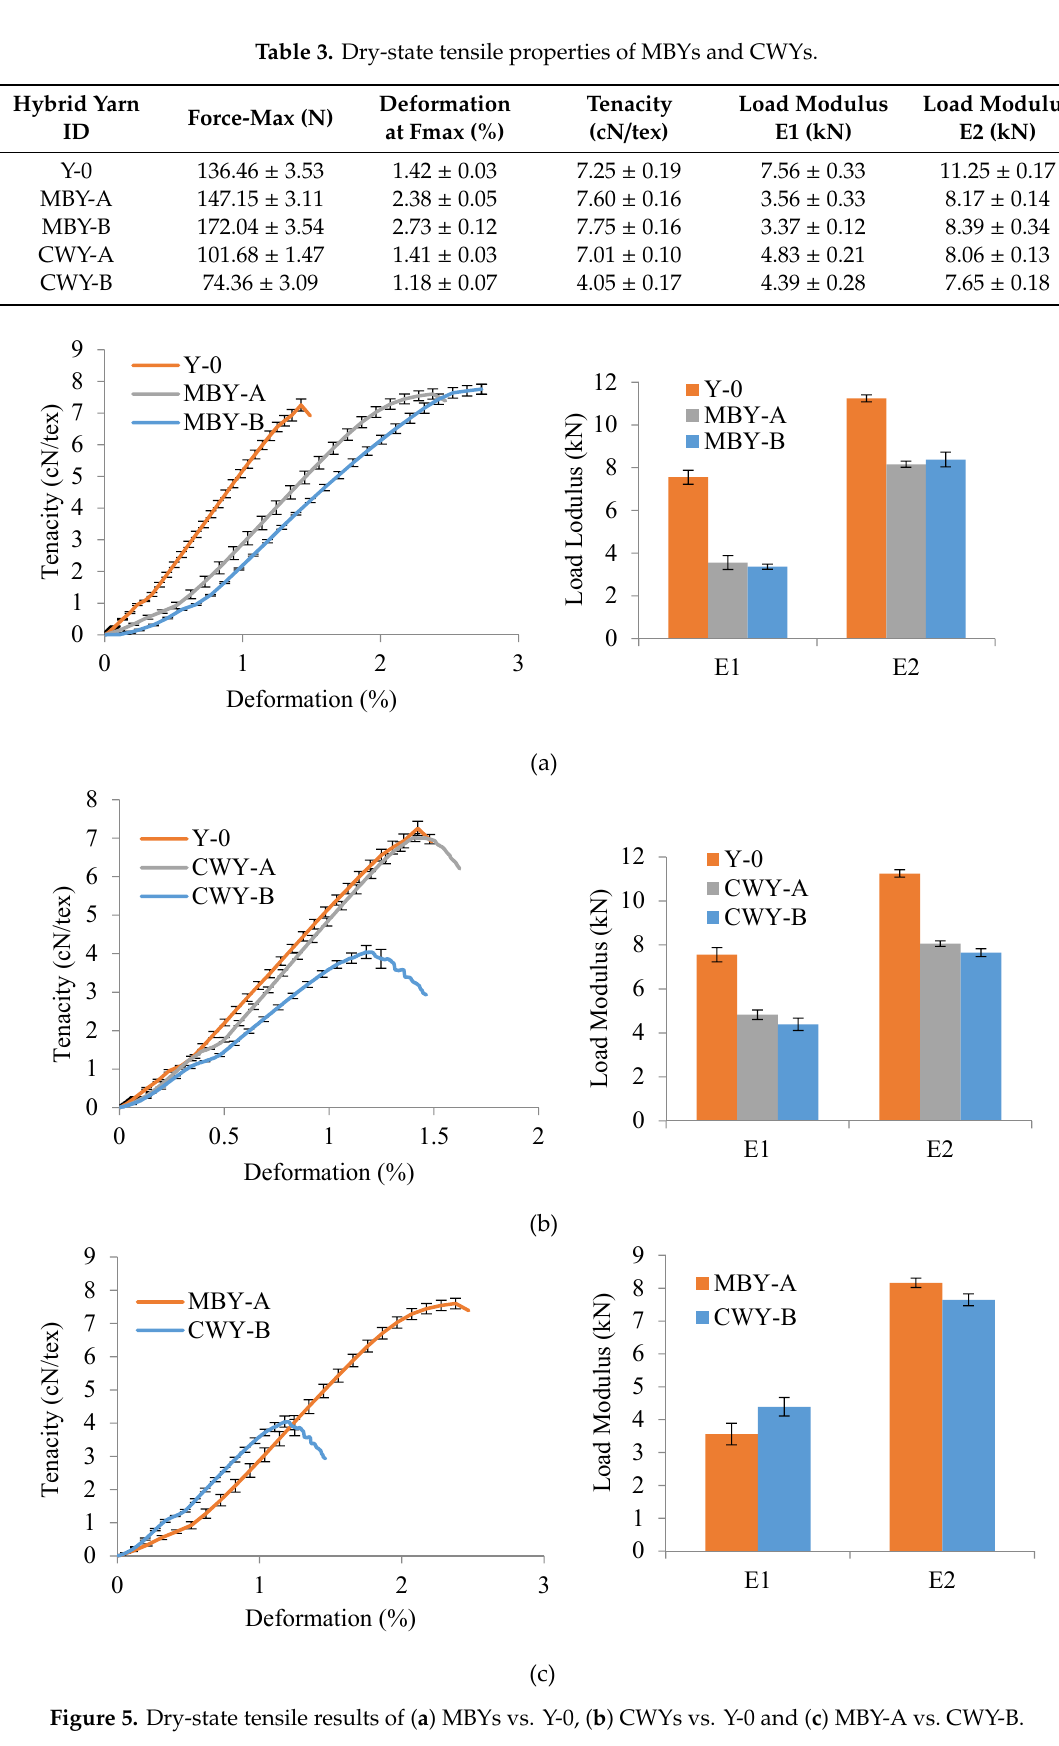
Figure 5. Dry-state tensile results of ( a ) MBYs vs. Y-0, ( b ) CWYs vs. Y-0 and ( c ) MBY-A vs. CWY-B. In Y-0, i.e., the reference, there was no damage and no cohesive effect between PP filaments and flax roving, so the tensile test results matched the pure flax roving tensile properties shown in Table 1. In MBYs, as the PP braiding angle appeared and increased, MBY-A and MBY-B exhibited